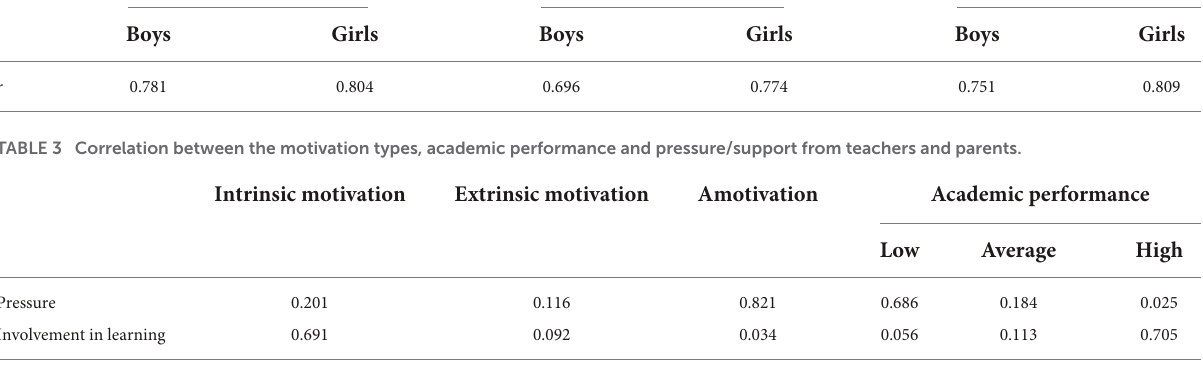
TABLE 4 PISA 2018 test results for Russia and Kazakhstan.